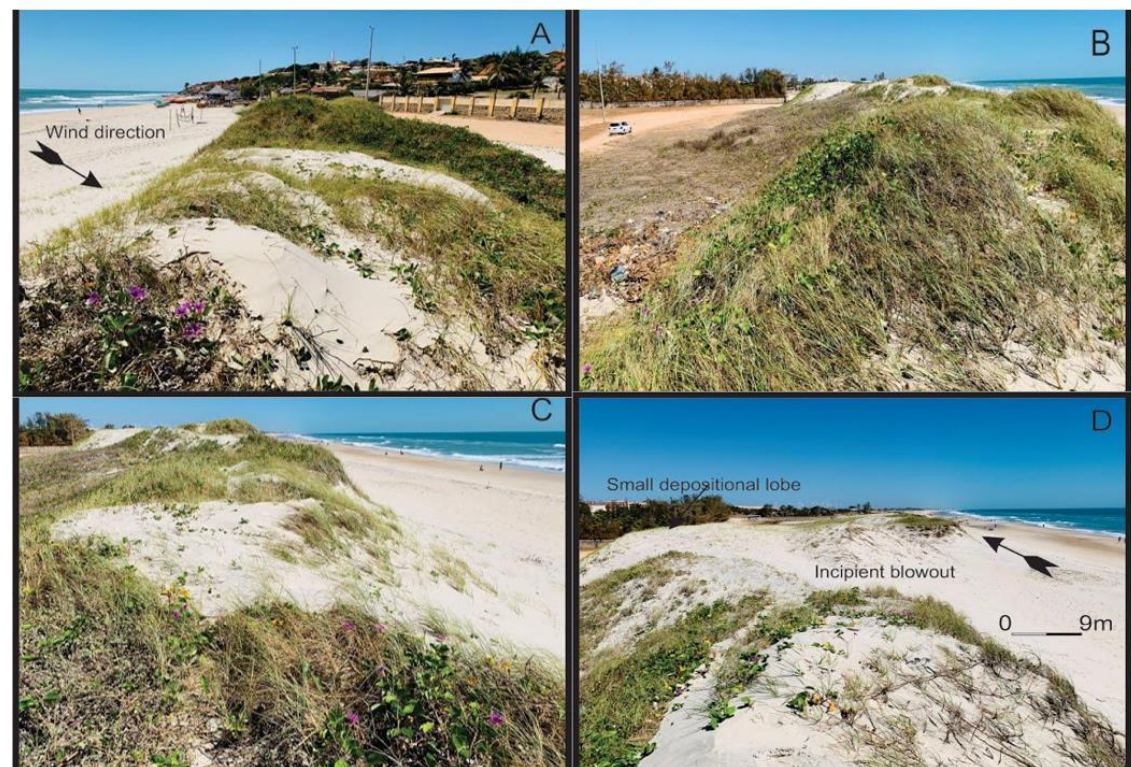
Figure 9. Foredune in Beberibe beach (see Figure 1) of about 4 m high and 50 m wide. ( A ) Photograph in the west–east direction, showing two points of sediment advancement over the vegetation. In the background, the promontory and the urban occupation in the surroundings are observed. ( B – D ) Photographs from east to west forward show the variation in vegetation cover ( B ) and the incidence of sedimentary flow covering part of the vegetation surface ( C ), as well as the formation of a small incipient blowout and development of depositional lobe downstream ( D ).